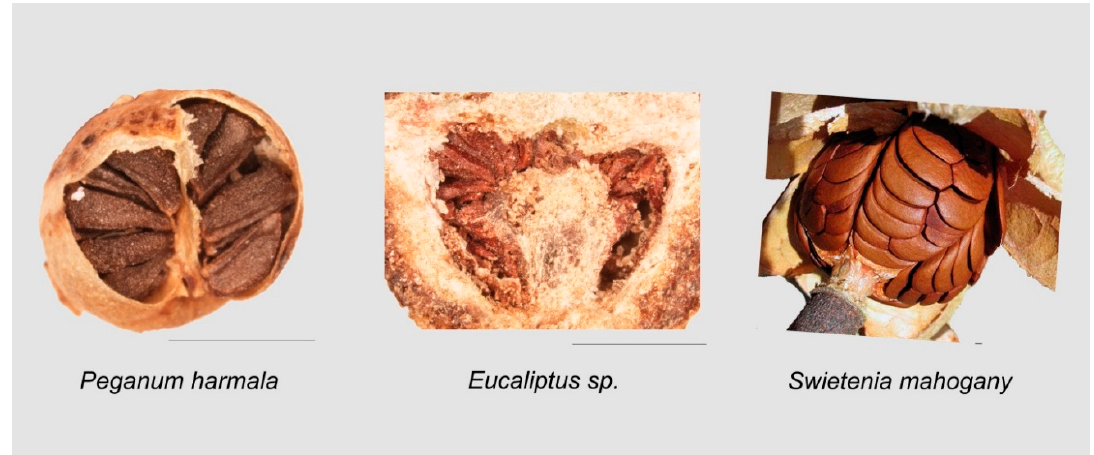
Figure 8. In fruits forming aggregates of seeds, the position of a seed in the aggregate determines their shape. Examples: Peganum harmala L., (Nitrariaceae); Eucalyptus sp. L’Hér. (Myrtaceae); Swietenia mahogany Jacq. (Meliaceae).